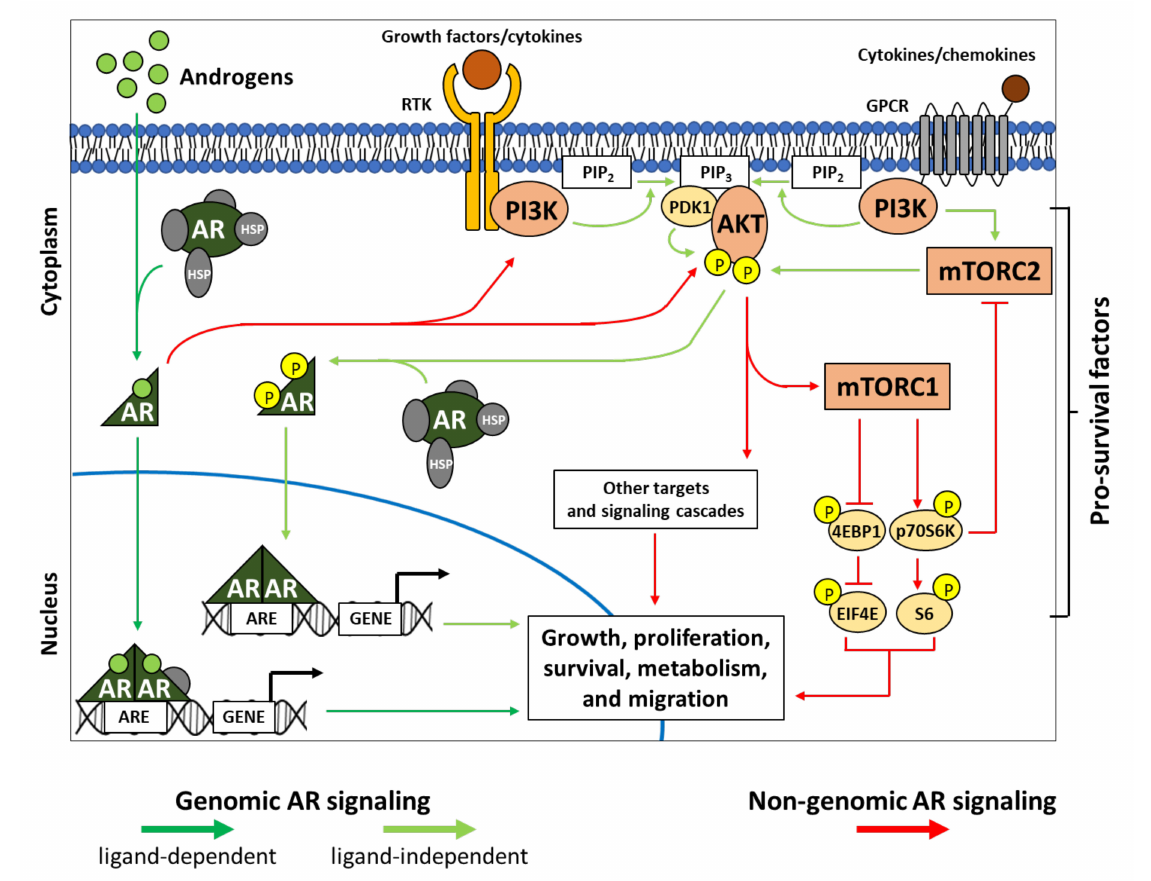
Figure 1. PI3K-AKT-mTOR interplays in genomic and non-genomic AR signaling. AR signaling can be classified into genomic and non-genomic signaling. Genomic AR signaling involves the translocation of activated AR into the nucleus, the binding to ARE of target genes, and the regulation of transcription activity. In contrast, non-genomic AR signaling does not require AR translocation and DNA binding. In general, AR activation is initiated from the binding of androgen to the receptor, which leads to conformational changes and dissociation of AR from chaperones such as HSPs. This is known as androgen- or ligand-dependent genomic signaling (dark green arrows). However, in the absence of androgens, AR can be activated via phosphorylation mediated by multiple cytoplasmic factors including AKT, a key biological processing factor of the PI3K-AKT-mTOR pathway. Thus, it is considered as ligand-independent genomic AR signaling (light green arrows). In turn, as non-genomic AR signaling (red arrows), the activation of AR can activate the PI3K-AKT-mTOR pathway by interacting with PI3K and AKT. Activation of PI3K-AKT triggers downstream effectors, including mTOR and other signaling cascades, leading to the promotion of growth, proliferation, survival, metabolism, migration, etc. AKT, protein kinase B; AR, androgen receptor; ARE, androgen response element; EIF4E, eukaryotic translation initiation factor 4E; GPCR, G-protein-coupled receptor; HSPs, heat shock proteins; mTORC1/2, mammalian target of Rapamycin complex 1/2; P, phosphorylation; PDK1, phosphoinositide-dependent kinase 1; PI3K, phosphatidylinositol-3-kinase; PIP 2 , phosphatidylinositol-4,5-biphosphate; PIP 3 , phosphatidyl-inositol-3,4,5-biphosphate; p70S6K, p70S6 kinase; RTK, receptor tyrosine kinase; S6, ribosomal S6 protein; 4EBP1, 4E binding protein